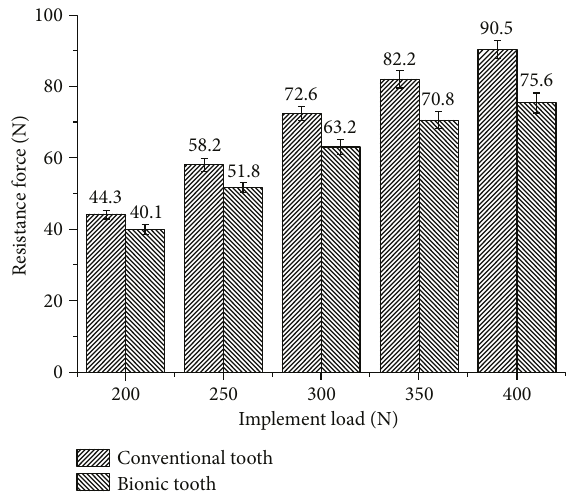
Figure 12: The test result of forwarding resistance for conventional and bionic toothed